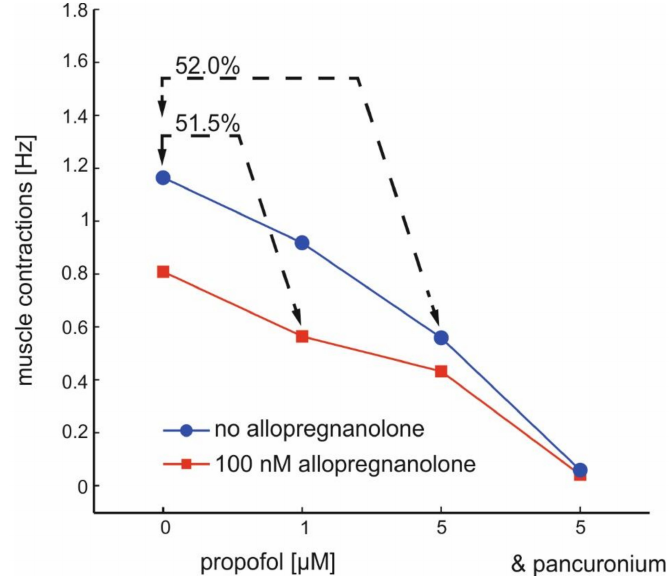
Figure 6. Interactions between allopregnanolone and propofol on the frequency of muscle contractions induced by α -motoneurons. The two lines show the concentration-dependent action of propofol in the absence (blue) and in the presence (red) of ALLO (100 nM). Note that the combined application of 100 nM ALLO and 1 µ M propofol reduces the muscle activity to almost the same level as observed after exposure to 5 µ M propofol. Furthermore, the e ffi cacy of ALLO in further reducing muscle contractions is low at the highest propofol concentration (5 µ M). Muscle contractions are almost completely depressed by pancuronium (1 µ